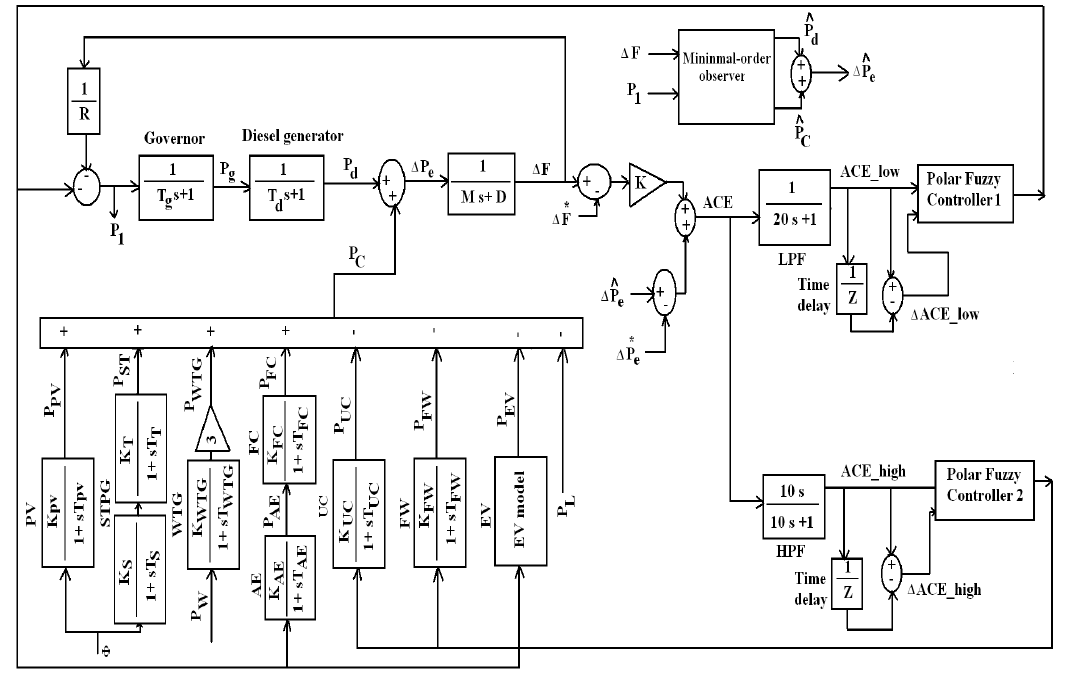
Figure 2. Block diagram of the proposed system. ACE, area control